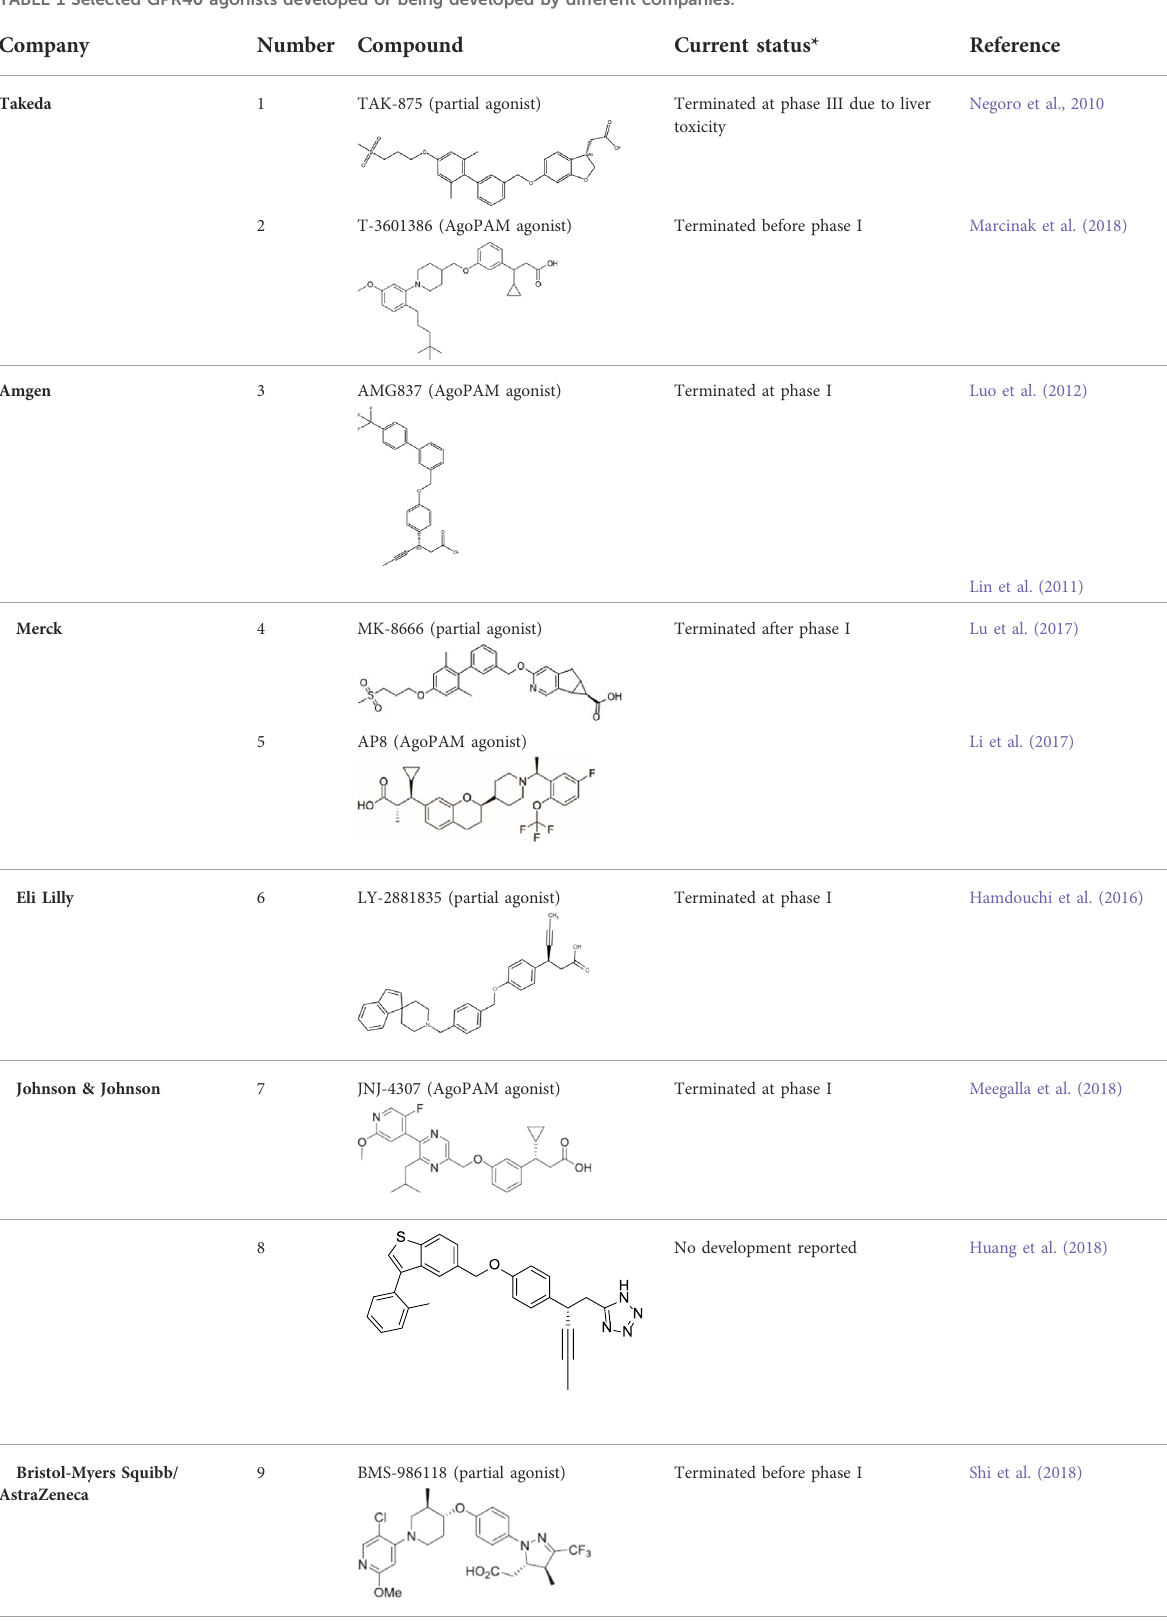
TABLE 1 Selected GPR40 agonists developed or being developed by different